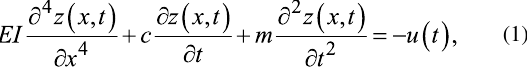
elasticity modulus and the PSD model for a free cantilever and a cantilever in contact with the sample. The PSD is used because it is the ideal tool for treating the stochastic process in the frequency domain